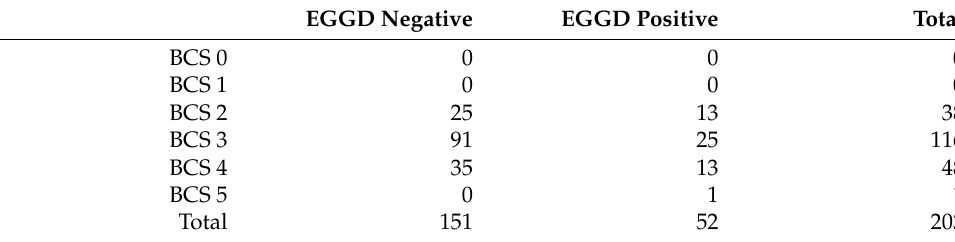
Table 2. Presence of EGGD in the different grades of BCS. EGGD was considered positive when any irregularity of the mucosa (hyperemia, erosions, or ulcers) was detected [1,2], and BCS was graded according to